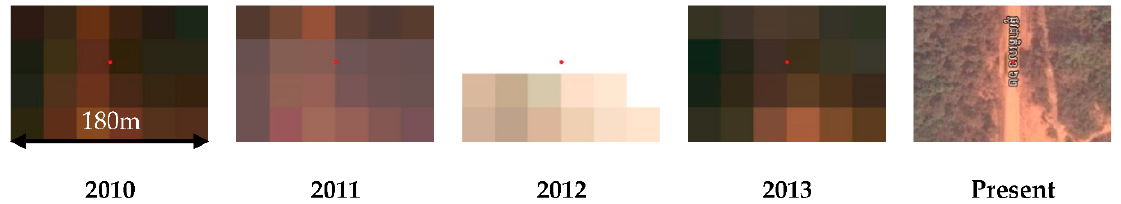
Figure 24. Satellite images of the O Thnol 3 bridge from which the year of construction cannot be judged.